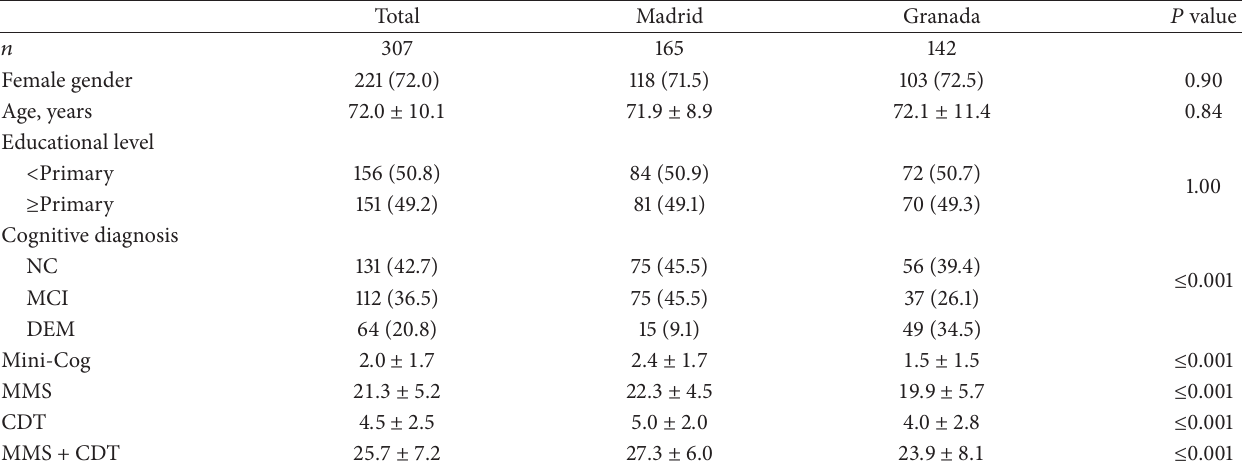
Table 1: Demographic and clinical characteristics of the total study sample and of the two original samples.